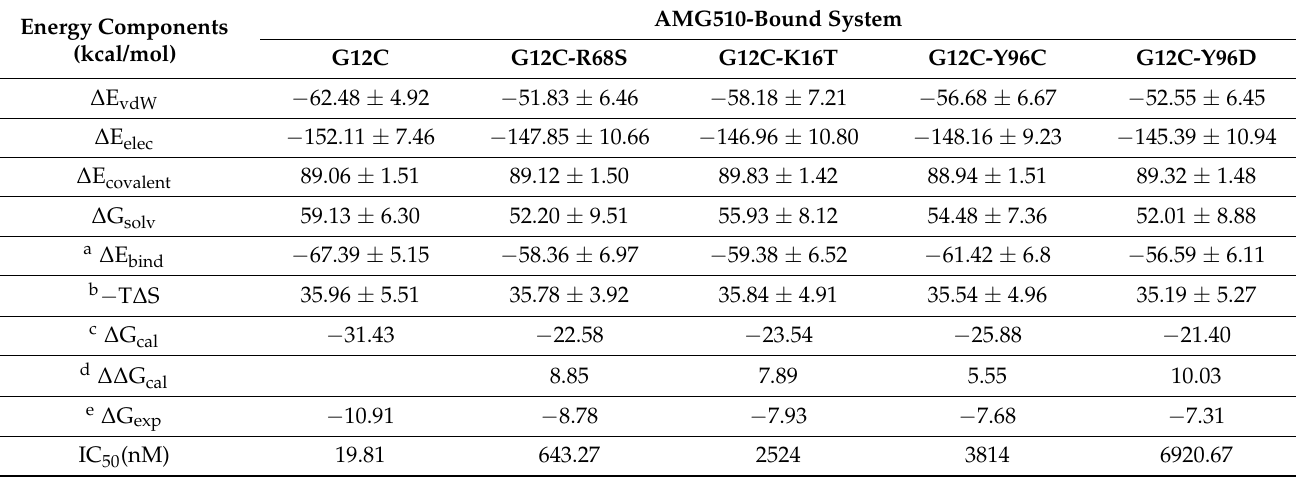
Figure 2. The correlation coefficient between experiment values (ΔG exp ) and the predicted binding free energies (ΔG cal ) obtained with the MM/GBSA method for ( A ) AMG510-bound complexes and ( B ) MRTX849-bound complexes. The gray shaded regions represent the confidence interval. Table 1. Binding affinities of the AMG510 mutant complexes from calculation and experiment.